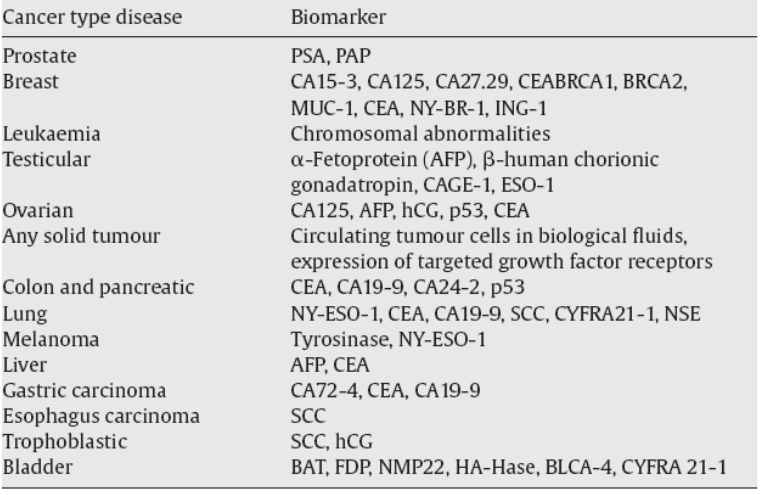
Table 3. Known biomarkers associated with cancer diagnosis and prognosis